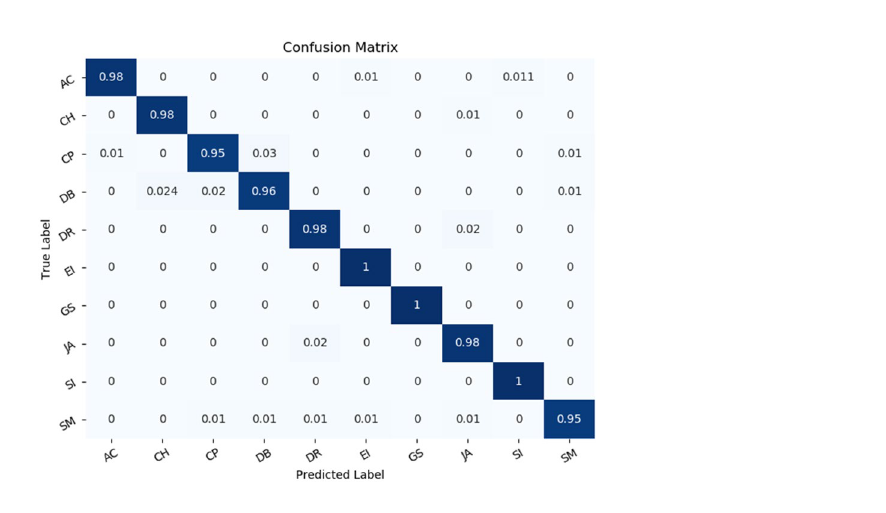
Figure 11. Confusion Matrix of RACNN on UrbanSound8K